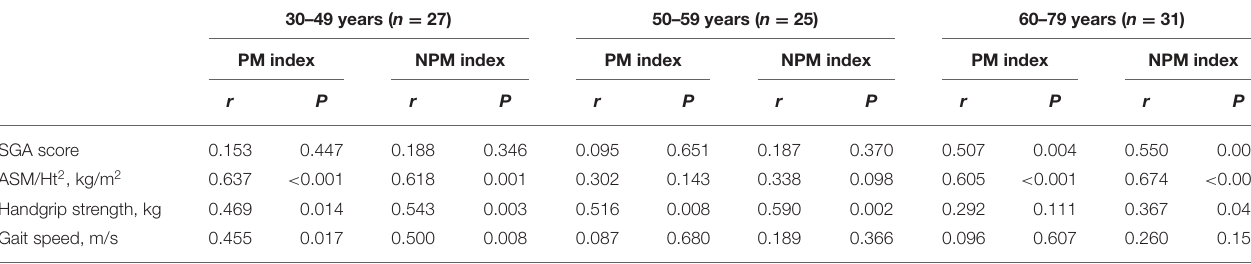
TABLE 2 | Correlation coefficients between the PM indices and various variables according to age groups.